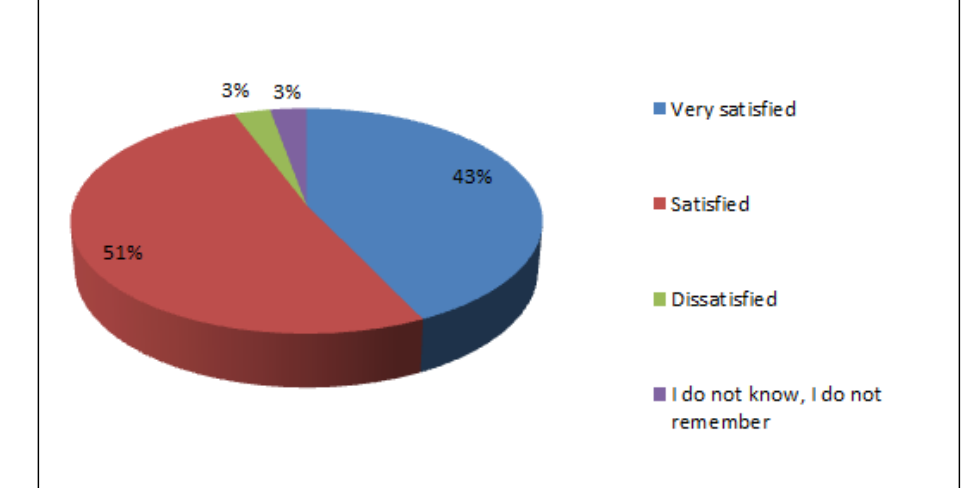
Fig. 8 Results of question 8: How do you evaluate a support from the competition announcer and